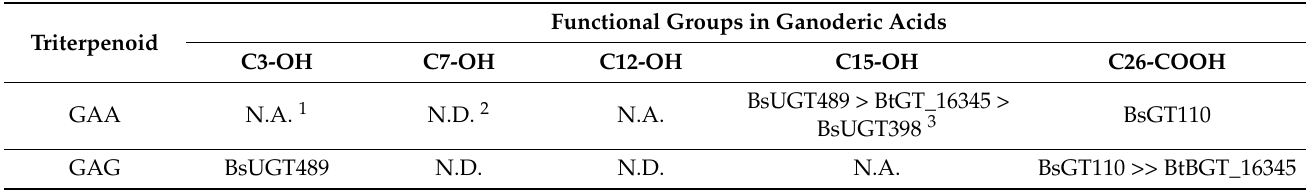
Table 1. Glycosylation activities of the four Bacillus glycosyltransferases (GTs) toward the different functional groups of GAA and GAG.